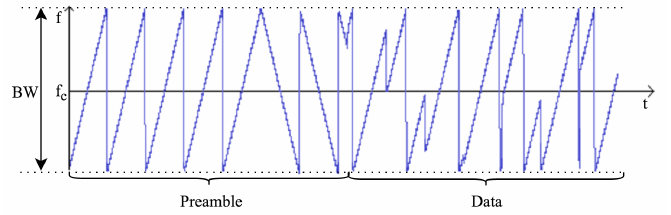
Figure 2. Frequency variation over time of a sample signal emitted by a LoRa transmitter. Data taken from [21]. f c is the central frequency of the channel, and BW is the